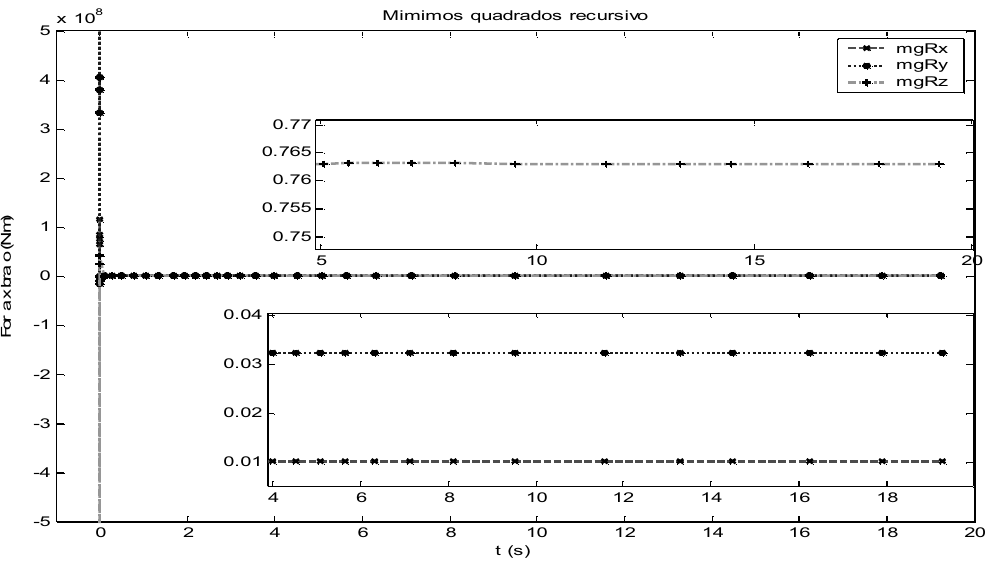
Fig. 4. External torque parameters